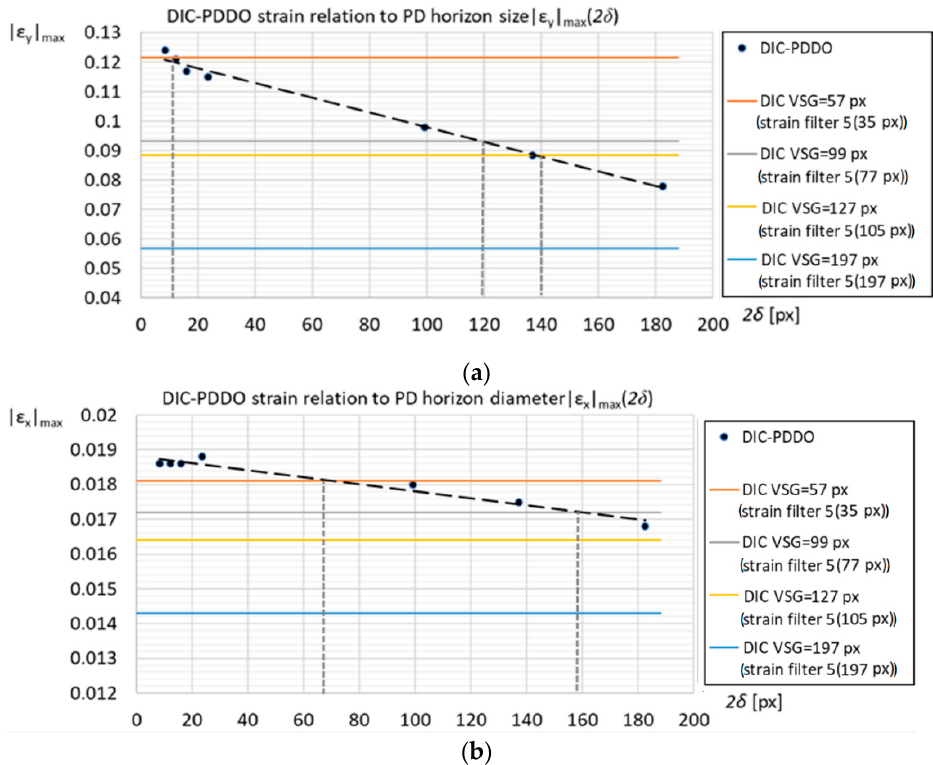
Figure 8. Effect of the PD horizon size on the strain values computed on in-house tensile experiment specimen surface by the DIC-PDDO method: ( a ) ε y strains, ( b ) ε x